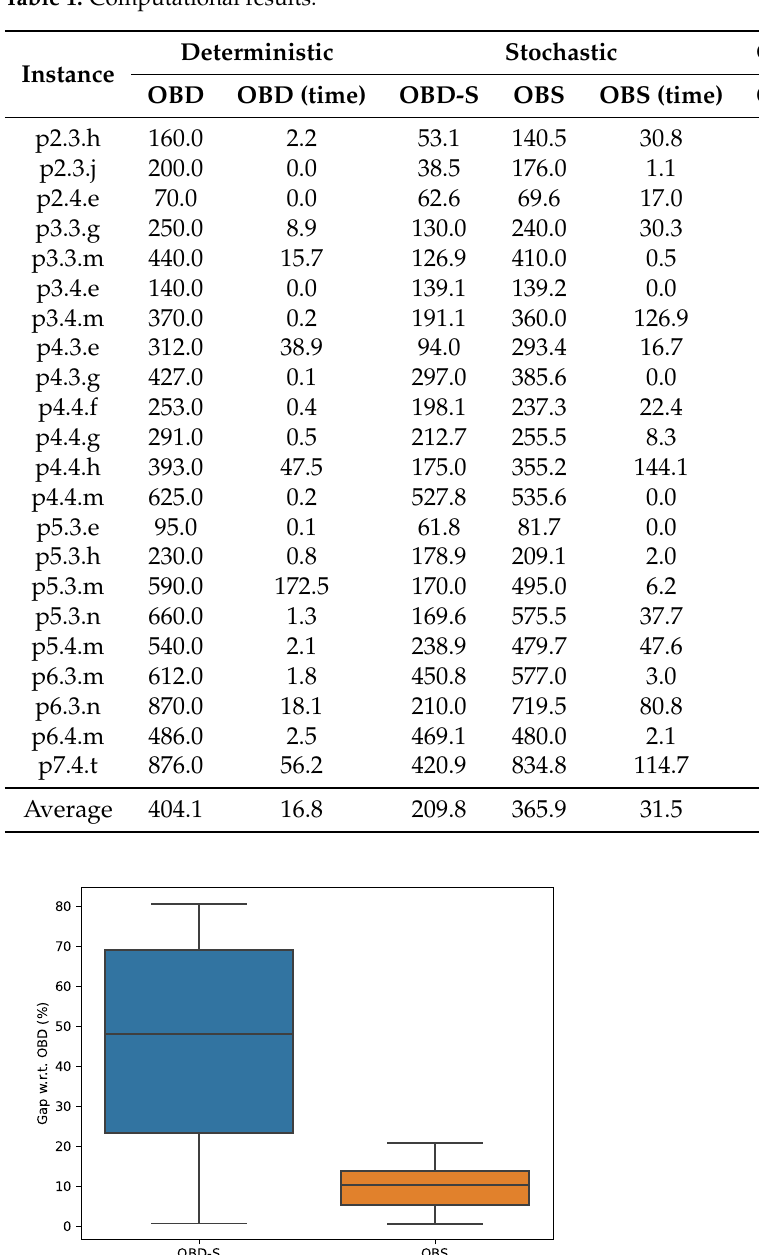
Table 1. Computational results.